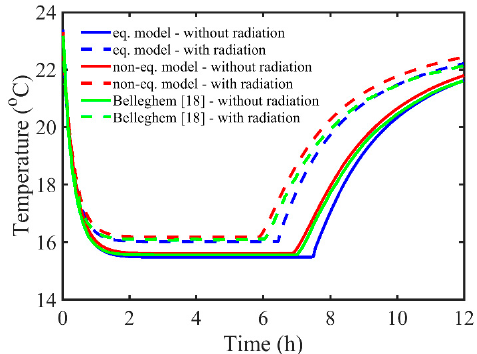
Figure 4. Temporal variations of temperature in the brick at 1 cm depth predicted with non-equilibrium and equilibrium models, compared with reference data [18]. Cases involving surface radiative heat flux are denoted with dashed lines, while the results without surface radiative heat flux are denoted with continuous lines.